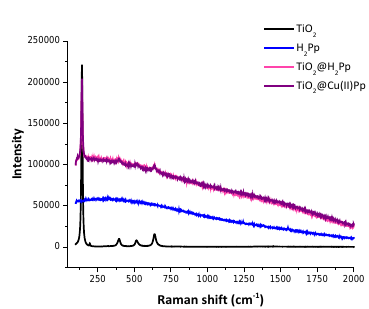
Figure 6. Raman spectra of TiO 2 , H 2 Pp, TiO 2 @H 2 Pp, and TiO 2 @Cu(II)Pp catalysts.